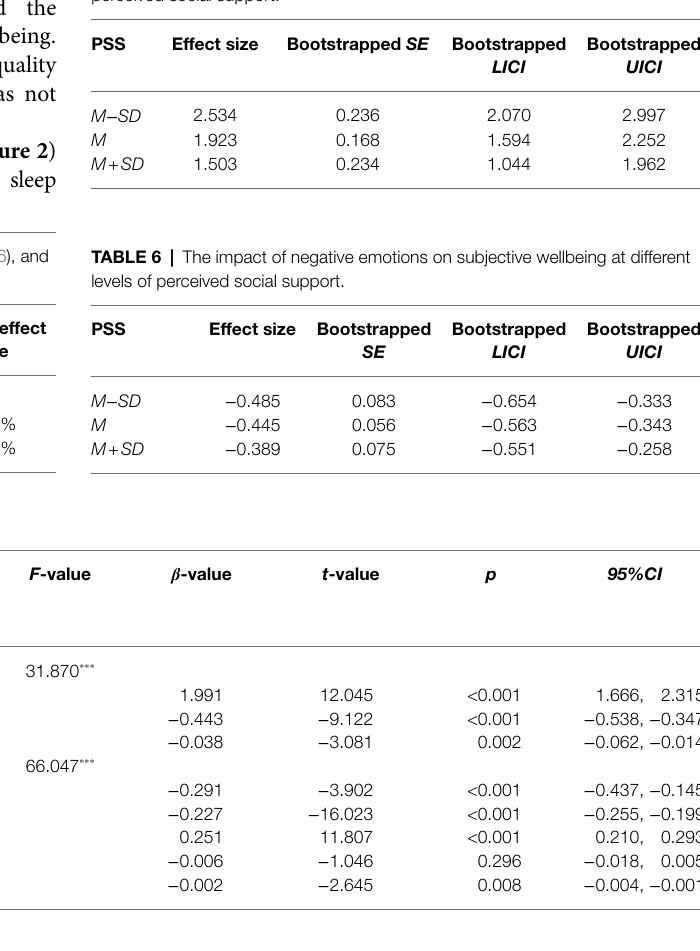
TABLE 5 | The impact of sleep quality on negative emotions at different levels of perceived social